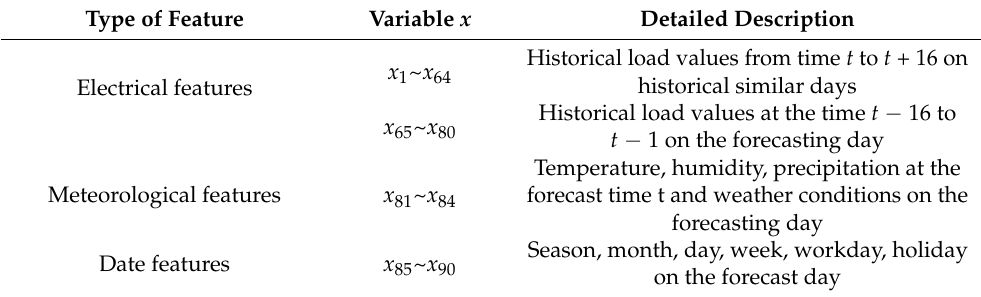
Table 11. Input variables description of ANN, LSTM, and CNN-LSTM models.